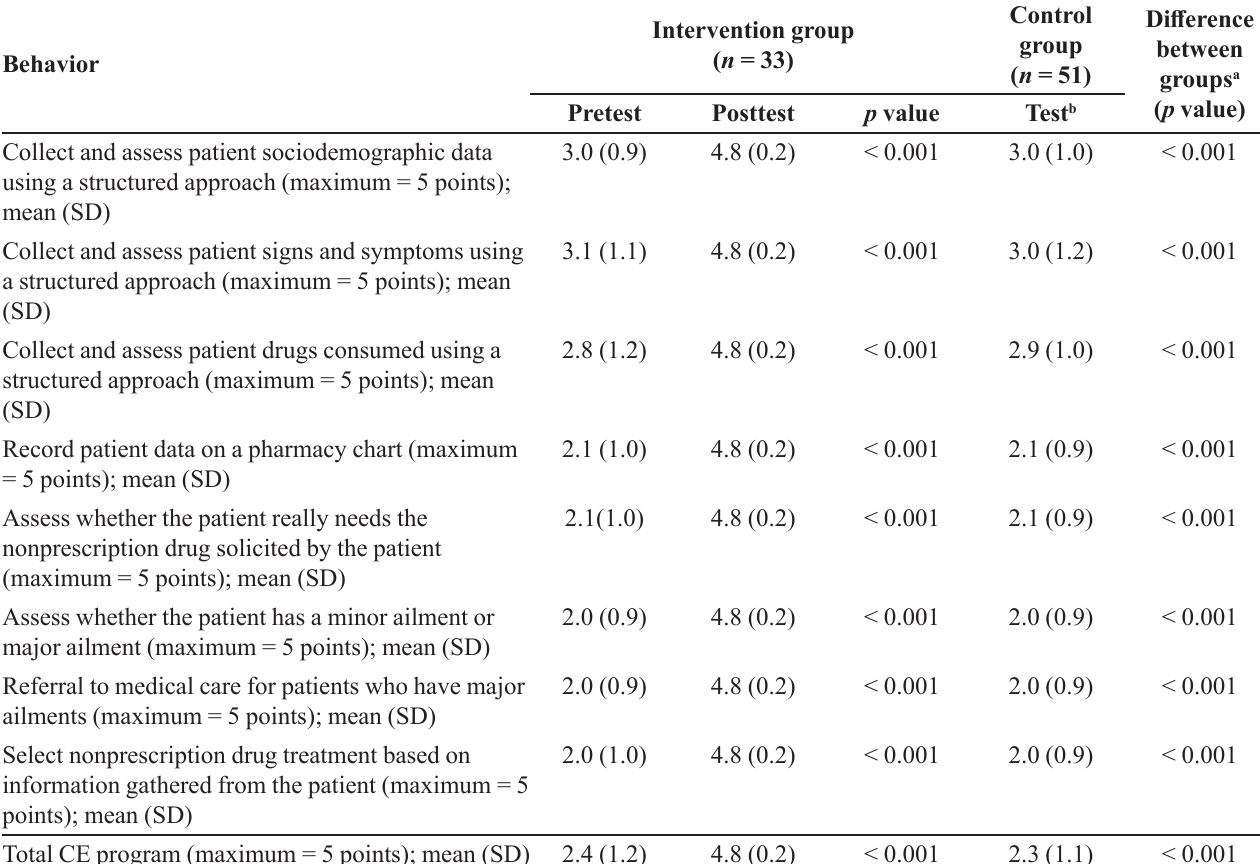
Intervention group